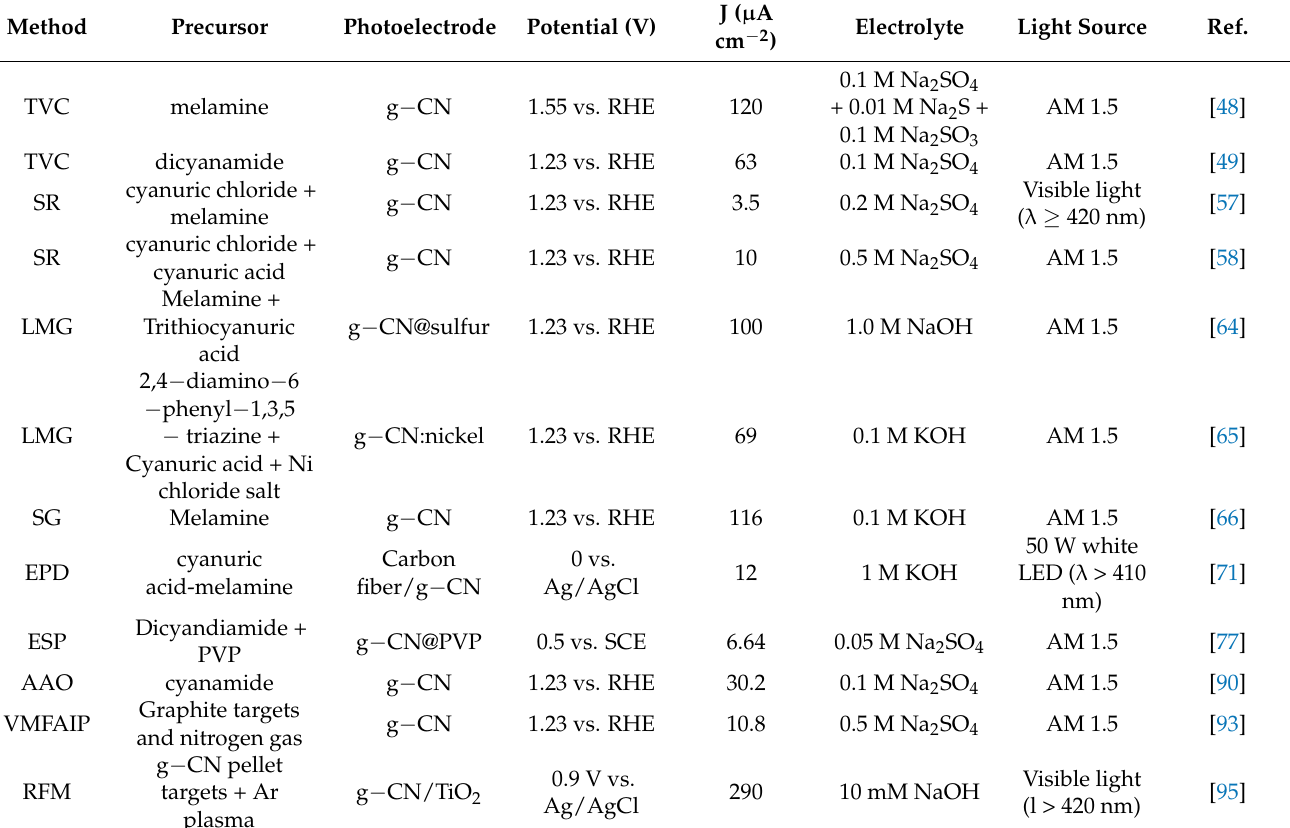
Table 2. Photocurrent response comparison of different